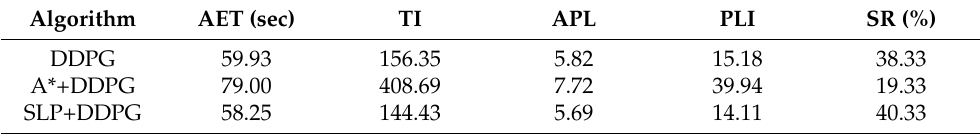
Table 5. Test Case 5 (Large-Scale Dynamic